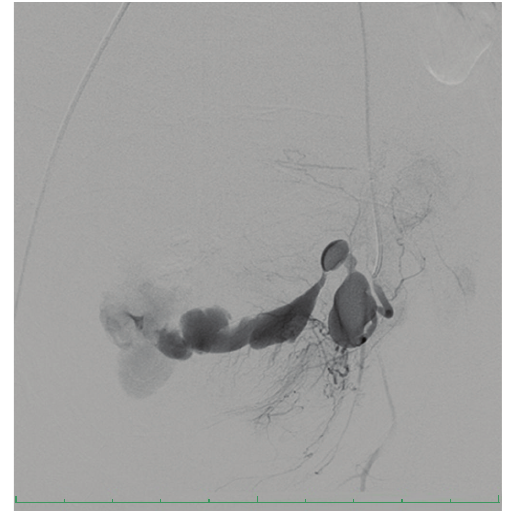
Figure 2: A selective left uterine artery angiogram reveals a pseu- doaneurysm with prompt and florid extravasation of contrast into the